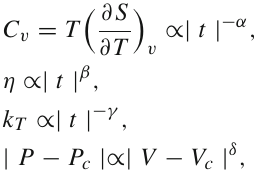
Fig. 3 Hawking temperature T versus Entropy S at constant electric charge e = 0 . 1 and magnetic charge g = 0 . 4. Left panel: a 2 = 1 and right panel: a 2 =